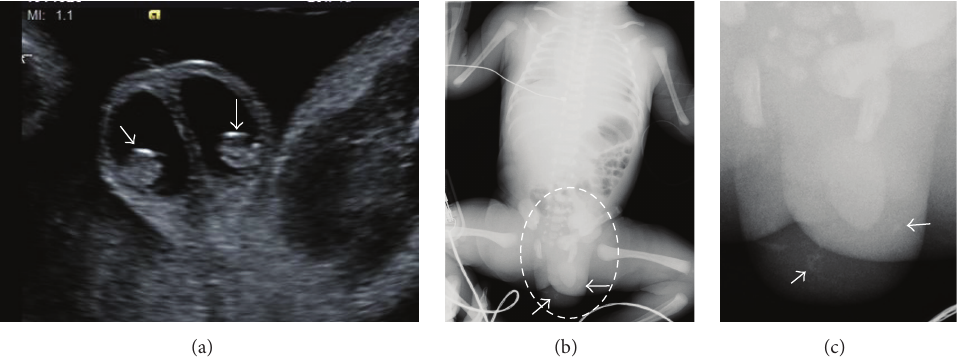
Figure 1: Prenatal ultrasonographic and postnatal radiographic findings. Prenatal ultrasonography revealed bilateral hydrocele with peritesticular calcification at 28 weeks’ gestation (a), while postnatal radiography demonstrated scrotal calcification without abdominal calcification (b, c). (c) was an enlarged view of the dotted circle in (b). Arrow indicated